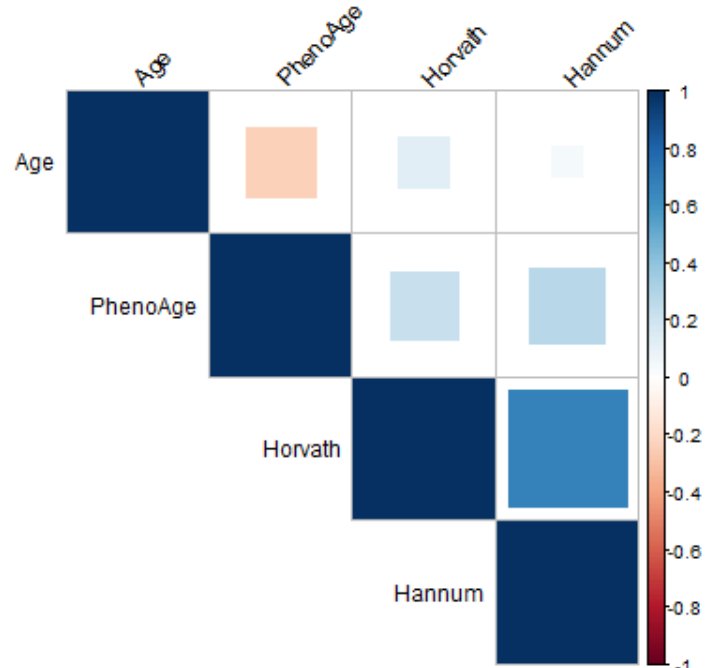
Figure 1. Correlation matrix of the epigenetic clocks and the chronological age. Note: The correlation was performed in both cohorts, Tlaltizapan and urban-raised, and collapsed. Blue colors represent a positive correlation, and red colors represent a negative correlation. The square size signifies the p -value of the correlation (the significance is directly proportional to the square size; all the correlations were statistically significant ( p -value < 0.05).